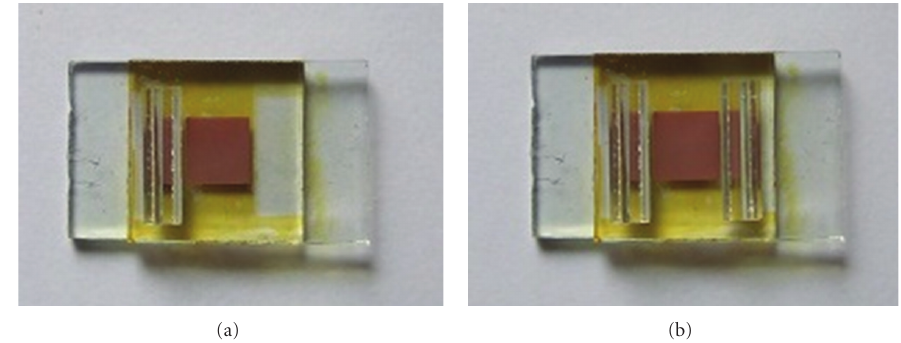
Figure 9: Photographs of DSSC with one EL (a) and two ELs (b).